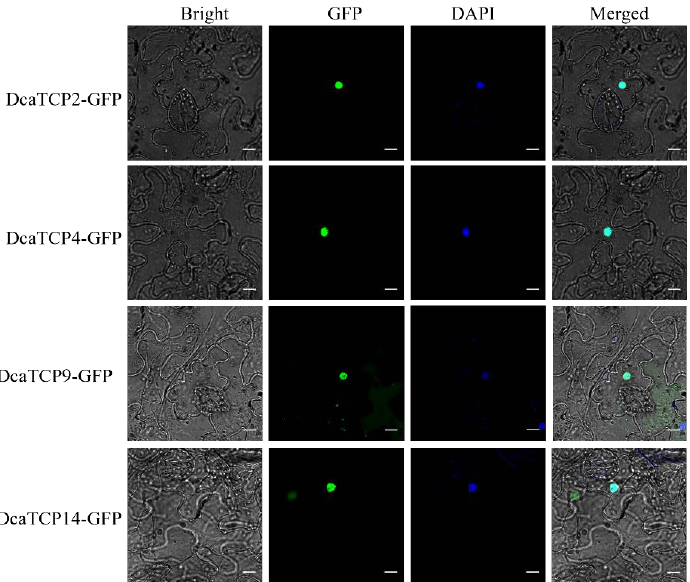
Figure 3. Subcellular localization of DcaTCP-GFP in Nicotiana benthamiana leaves.